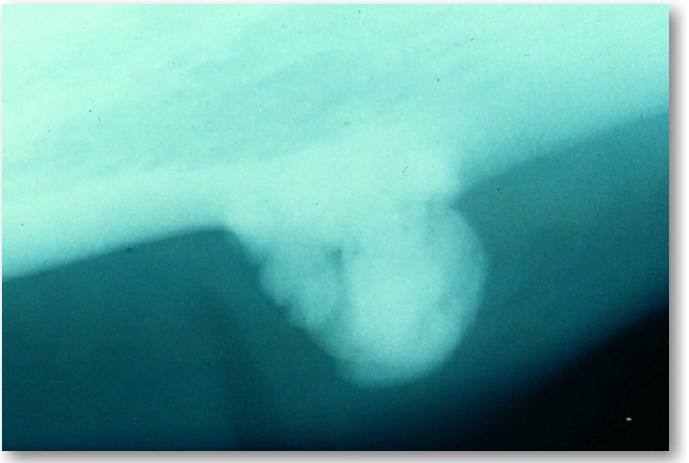
Figure 2. Plain radiography showing a peripheral osteoma involving the mandibular body.